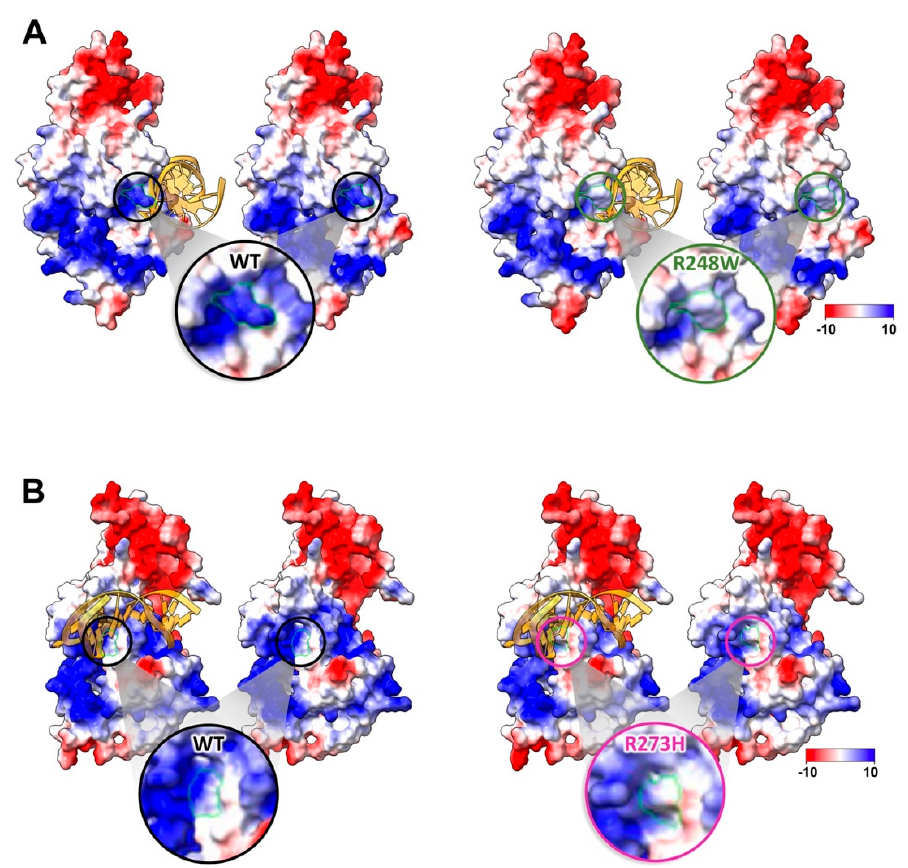
Figure 4. Contact mutations affect interactions with the DNA backbone through physical changes and differences in electrostatic charge potentials. Surface charge potentials are shown for residues R248W ( A ) and R273H ( B ) in the presence and absence of a DNA fragment (DNA model from pdb code, 2AC0). Magnified views show changes in hotspot residues with respect to WT p53. Green borders indicate regions of differences. Scale for acidic to basic residues ranges from − 10 (highly negative) to 10 (highly